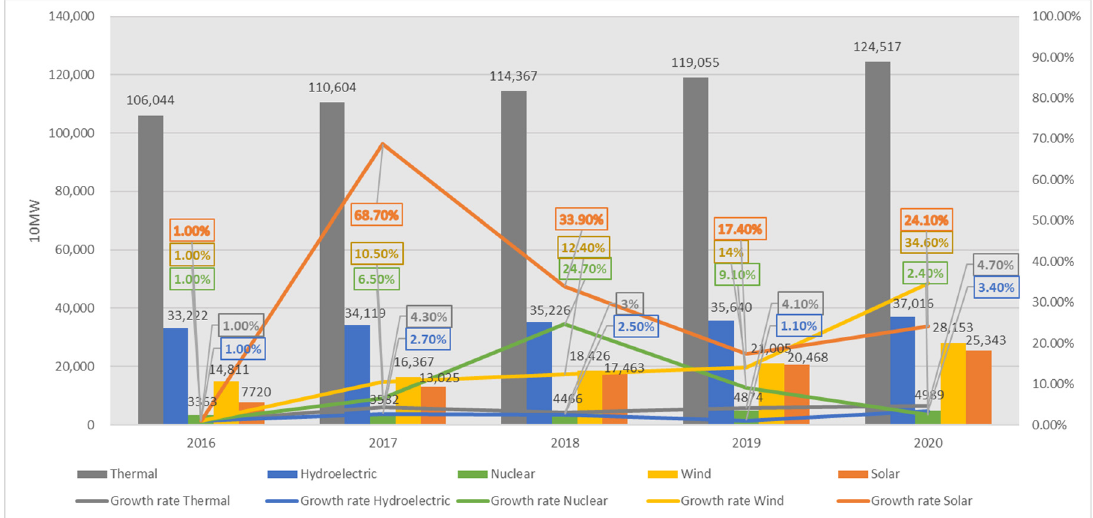
Figure 1. Installed power generation capacity and growth rate in China. Source: table of national power industrial statistics from 2017 to 2020 released by the National Energy Administration.